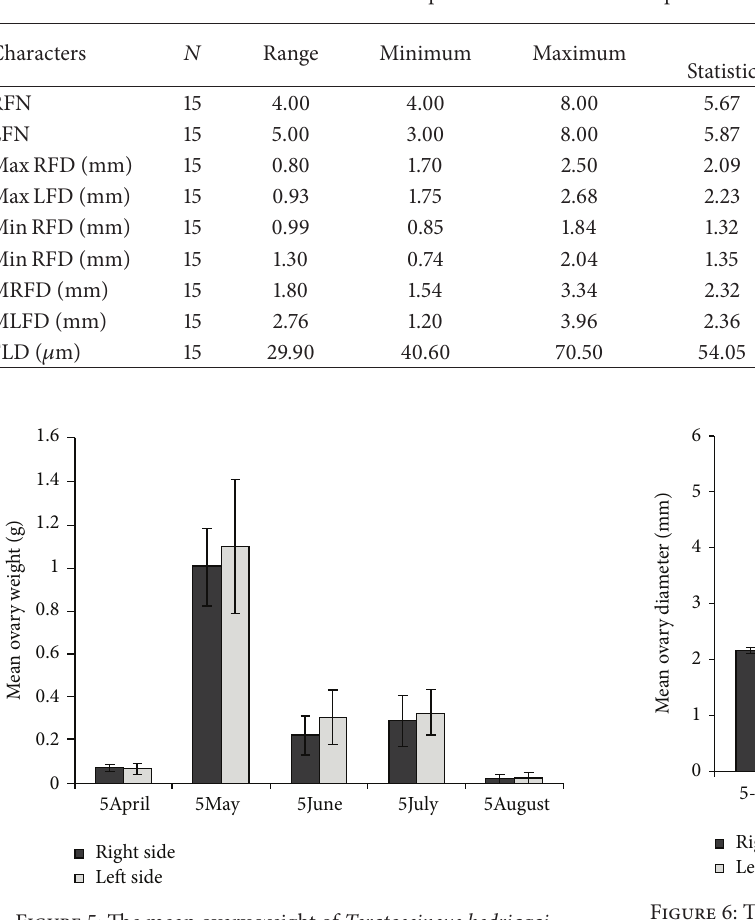
Table 2: Descriptive statistics of microscopic characters in T . bedriagai .